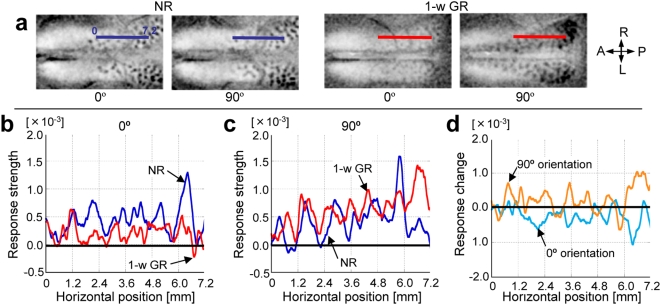
Comparison of orientation selectivity before and after GR.(a): single-orientation maps representing responses to 0° and 90°, constructed at P28 in a normally reared kitten (NR) and at P38 immediately after 1-week vertical-GR in the same animal (1-w GR). Darkness in the maps indicates the strength of responses to stimulus orientations. Horizontal lines drawn inside functionally defined area 17 are superimposed on the maps and placed on the corresponding cortical position. Length of the lines, 7.2 mm. (b): profiles of response strengths for 0° before and after GR along the horizontal lines (blue: before; red: after). (c): those for 90°. (d): profiles of changes in response strengths through GR (differences between the two curves in b and c). Orange: 90°; sky blue: 0°. We carefully calibrated the baseline level of responses so that the response strength averaged over the range of the 2.4-mm extension of the horizontal lines into functionally defined area 18, either before or after GR. Stimulus gratings of a 0.5 c.p.d. spatial frequency presently used do not evoke area 18 (see Materials and Methods).